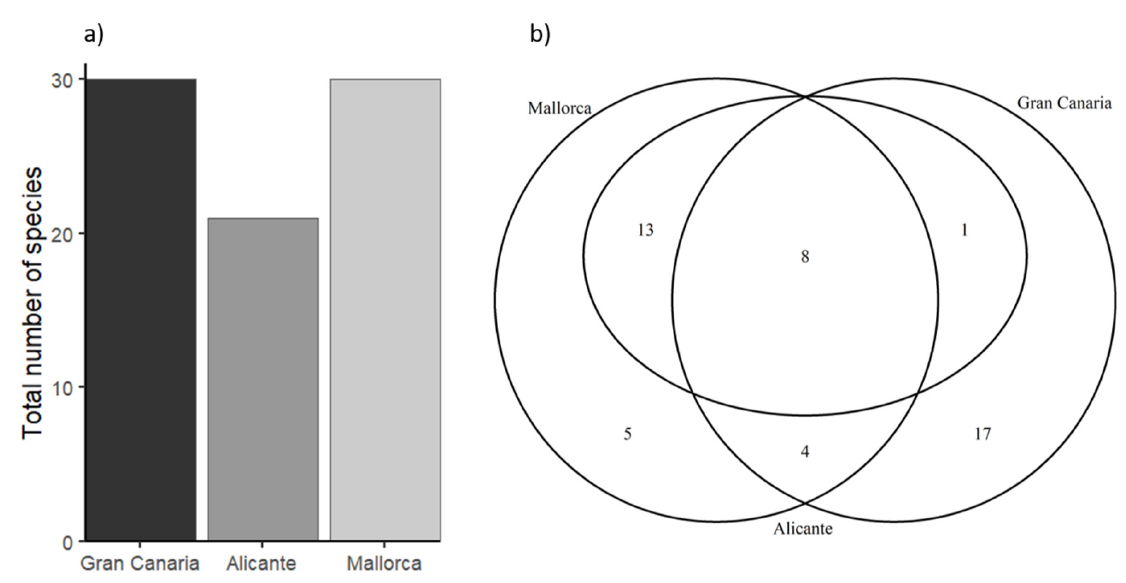
Figure 4. ( a ) Total number of fish species at each region, and ( b ) Venn diagram denoting similarities in fish assemblage composition between regions (numbers within the circles denote number of shared species).